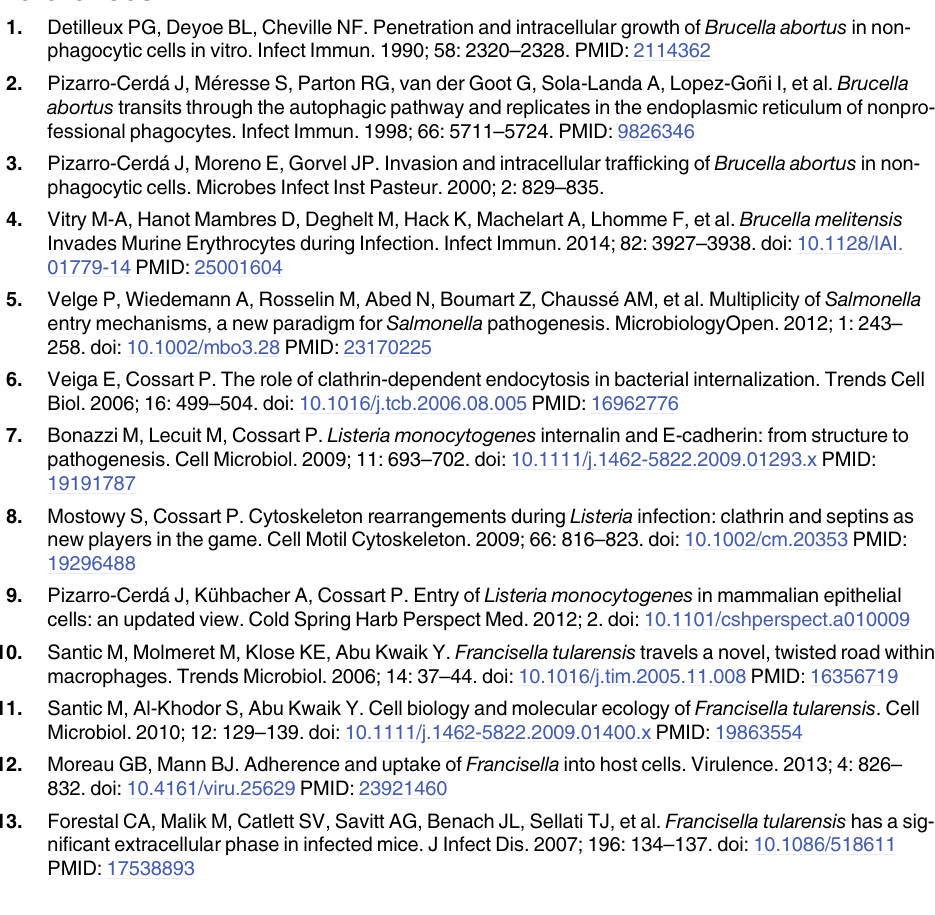
S1 Table. Viability of bacteria inside the B cells.BALB/c mice were infected with F . tularen- sis LVS/GFP. After 24 h peritoneal cells were collected, resuspended in DMEM cultivation medium supplemented with 2% fetal bovine serum and then incubated with the antibody CD19-Alexa Fluor 647. Peritoneal CD19 + cells were sorted using BD FACSAria II Cell Sorter. Sorted CD19 + cells were washed using PBS and lysed by 0.1% sodium deoxycholate after wash- ing. Actual numbers of bacteria were determined by serial dilutions (10 0 and 10 − 2 ) and the number of CFU was calculated. 1 Number of CD19 + cells seeded onto McLeod plates in volume 50 μ L and cultivated at 36.8°C. 2 The number of CFU was determined after 48 – 72 h of cultiva-